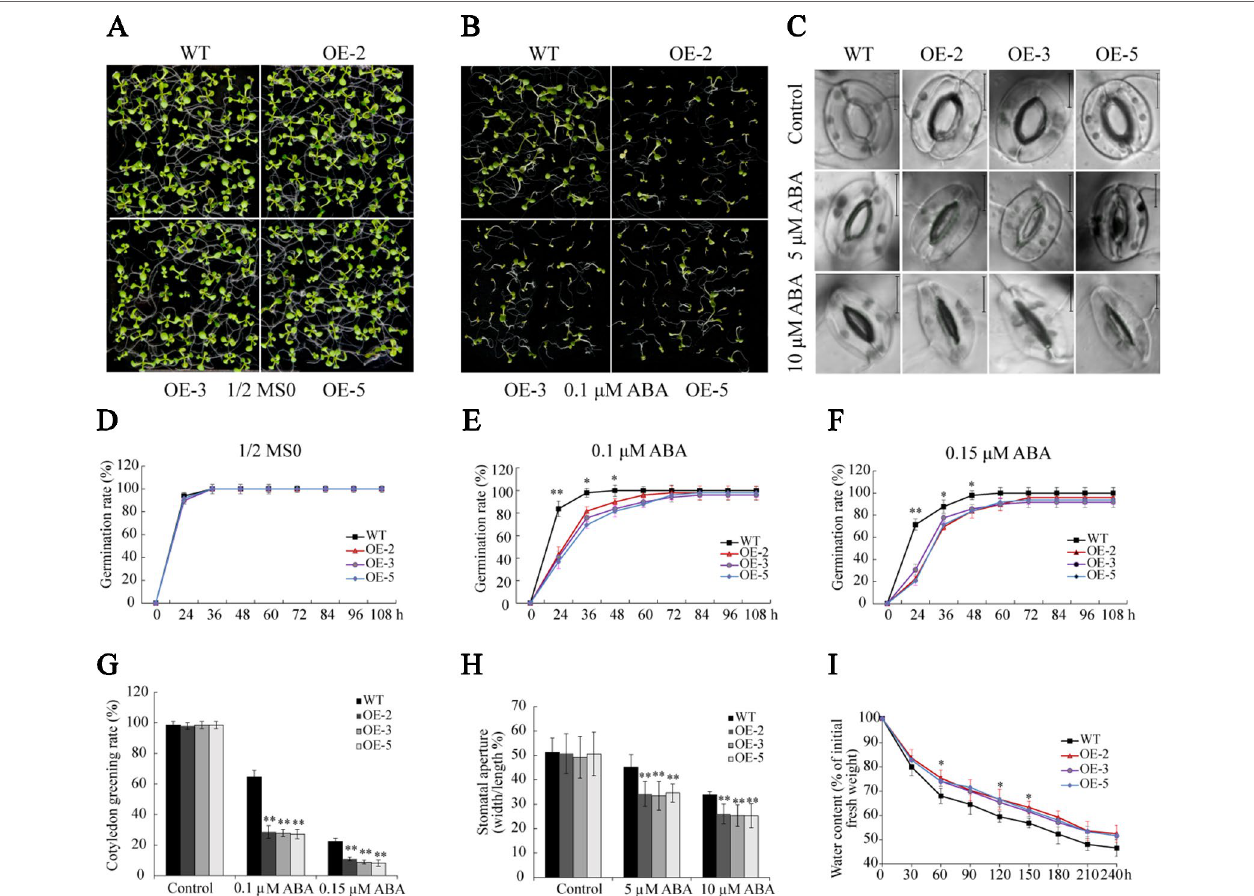
FiGURe 12 | Overexpression of GmSAP16 increases abscisic acid (ABA) sensitivity in Arabidopsis . Germination assays of wild-type (WT) and GmSAP16 transgenic Arabidopsis seeds under normal conditions (A) and ABA treatment (B) . Stomatal aperture assays were conducted with different concentrations of ABA (0, 5, 10 μM) (c) . Germination rates of WT and GmSAP16 -overexpressing seeds on 1/2 Murashige and Skoog (MS) medium (D) , 1/2 MS medium containing 0.1 μM ABA (e) , and 1/2 MS medium containing 0.15 μM ABA (F) . At least 80 seeds of each genotype were used in the germination assays. (G) Measurement of cotyledon greening rate. (h) Measurement of stomatal aperture. At least 30 stomata were measured, and the aperture was calculated by width/length. (i) Relative water content of WT and GmSAP16 -overexpressing Arabidopsis . A total of 1.0 g of fresh weight Arabidopsis seedlings was sampled for measurement at the indicated time points. Three biological replicates were performed, and error bars indicate ± SE. Asterisks represent significant differences compared with the corresponding controls. (*, P 0.05; and **, P 0.01; Student’s t